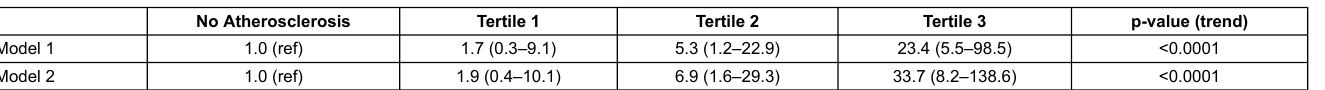
Table 2: Hazard ratios (95% confidence intervals) for cardiovascular end points associated with total plaque area (TPA) tertiles adjusted for traditional cardiovascular risk factors (model 1) and for PROCAMca, SCOREca, and FRAMca (model 2). No